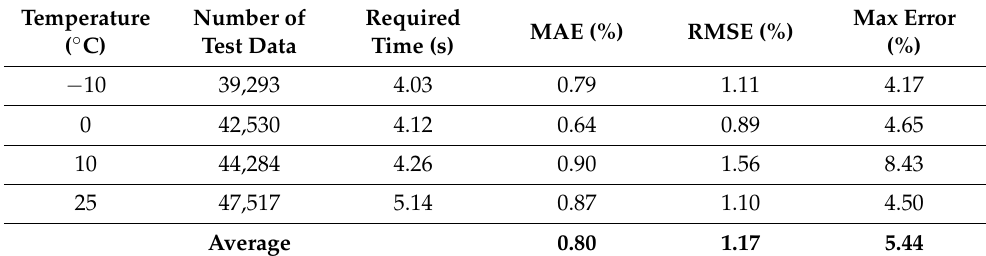
Table 2. Test results of the LSTM